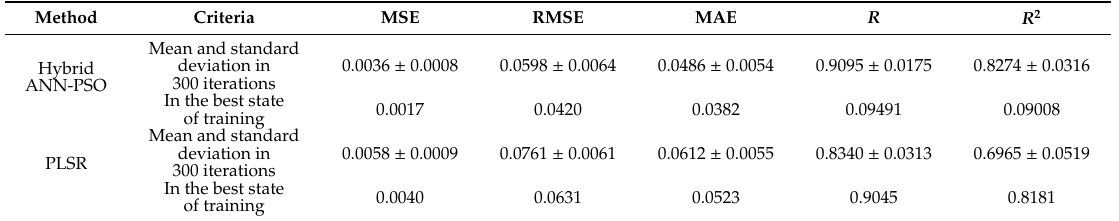
Figure 10. Graphic study of the performance of Methods. ( a ) ANN-PSO Algorithm and ( b ) PLSR for predicting the titratable acidity of Gala apples using spectral data related to key wavelengths. Table 13. Comparison of mean and standard deviation, different criteria evaluating the performance of the ANN-PSO algorithm and PLSR for estimating TA in 300 iterations using spectral data of key wavelengths.